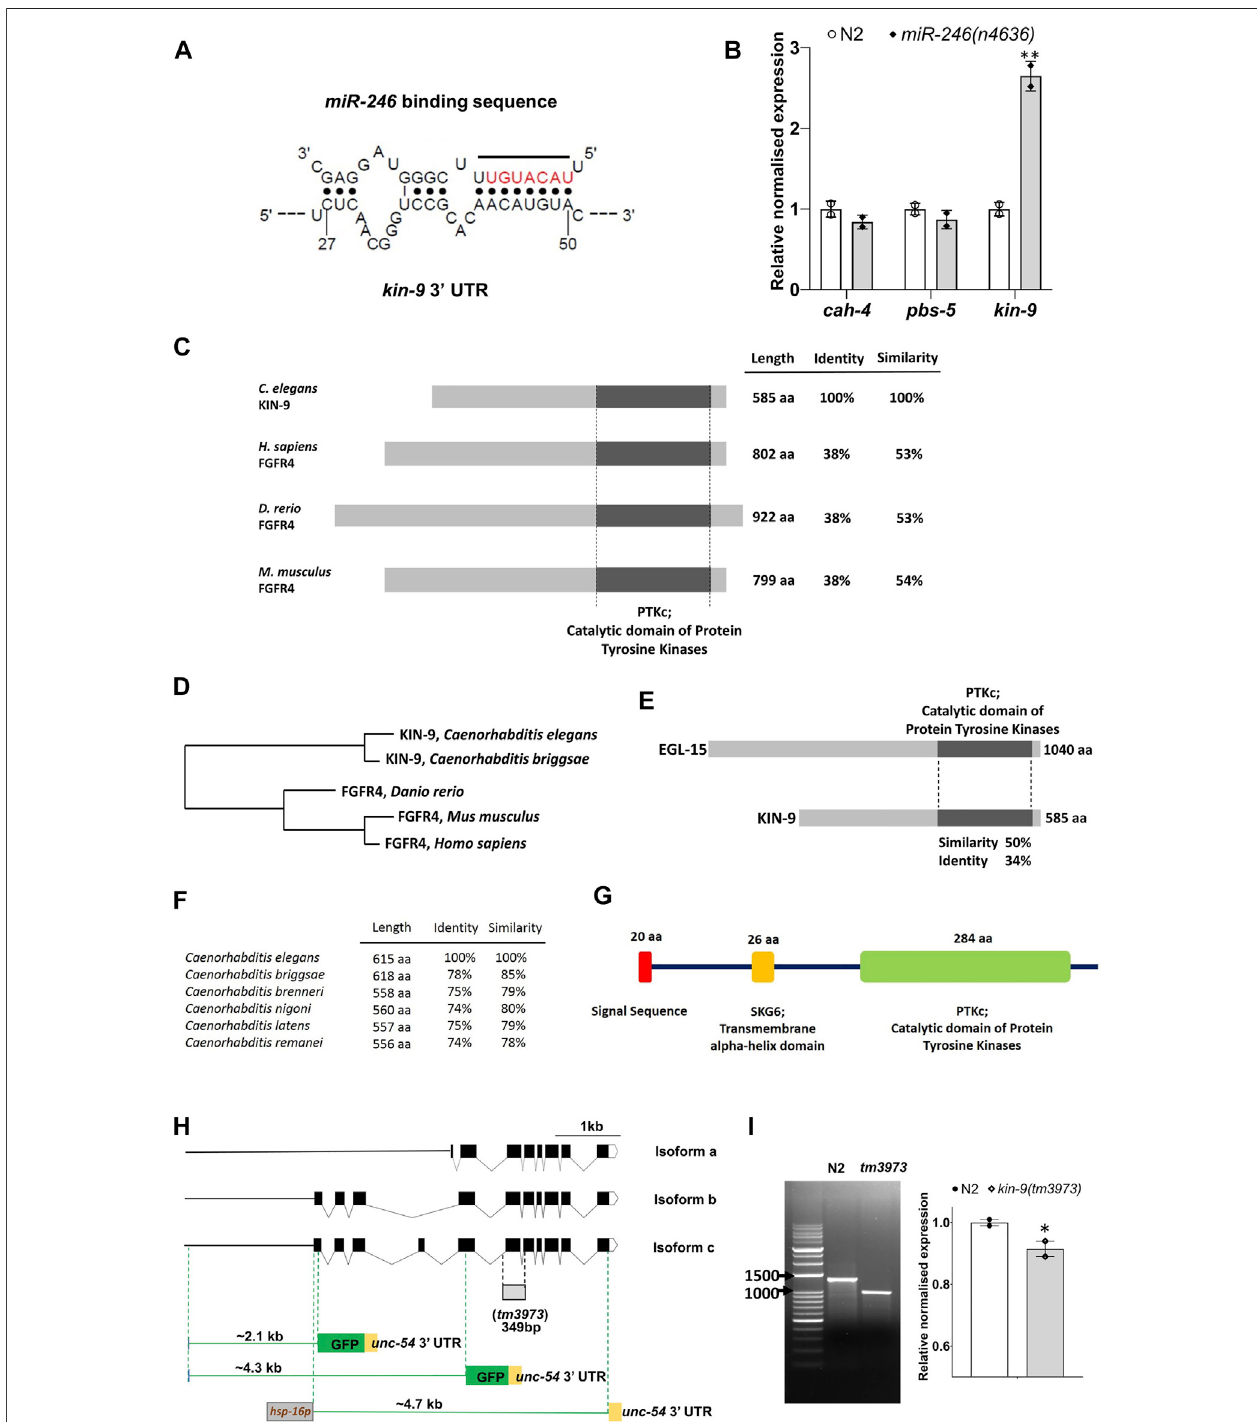
FIGURE 1 | miR-246 mutants show overexpression of kin-9 . (A) The predicted binding site of miR-246 at the 3 ′ UTR of kin-9 mRNA. (B) Expression analysis of three candidategenes cah-4,pbs-5 and kin-9 inthe miR-246 mutants. (C) Schematicrepresentation ofKIN-9andFGFR4 proteins from Caenorhabditiselegans , Homo sapiens, Danio rerio , and Mus musculus with percent identity and similarityindicated relative to C. elegans KIN-9. Conserved domains are aligned and are depicted with sizes, all presented to scale. (D) Phylogenetic tree of proteins shown in panel (C). (E) Schematic representation of C. elegans KIN-9 and EGL-15 proteins with percentidentityandsimilarityindicated. (F) SimilaritiesandidentitiesbetweentheKIN-9proteinsinthe Caenorhabditis genus. (G) ProteindomainsandstructureofKIN-9 protein. (H) Schematic dendrograms showing all the isoforms and tm3973 deletion allele of kin-9 with exons (black solid boxes), introns (bent lines) and upstream